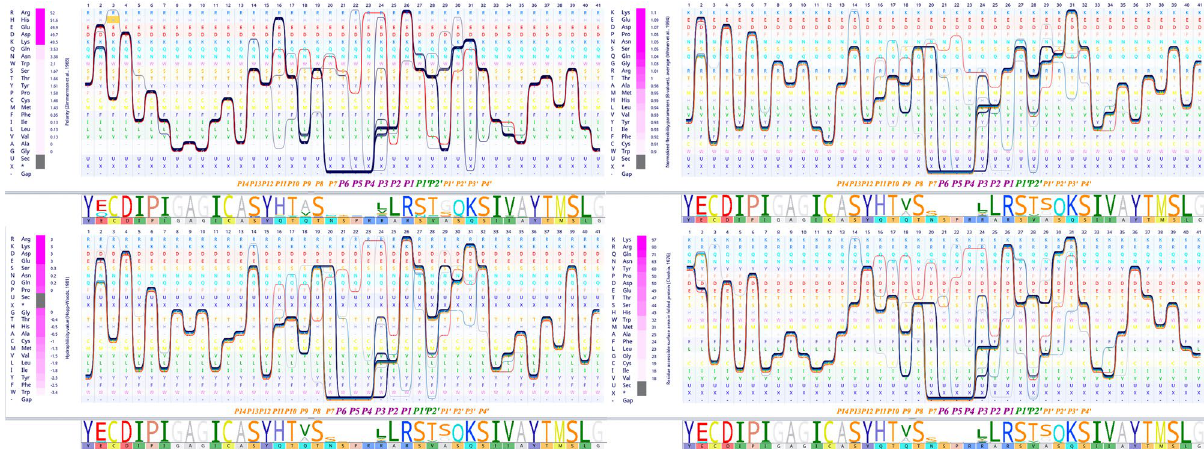
Figure 7. Comparison of the chemical properties of the furin cleavage site of SARS-CoV-2 spike glycoprotein with other coronaviruses. Four chemical properties of the furin cleavage site are compared with other coronaviruses by bundle illustrating the MSA. In each panel, the amino acids are sorted based on different chemical properties. The sequence logo and the sequence of SARS-CoV-2 spike glycoprotein furin cleavage sites are presented below each panel. The 20 amino acids of the furin cleavage motif are depicted by different colors on the top of the sequence alignment logo. The color scheme of fonts is based on the reference 38 . The red line in each panel is the sequence of the SARS-CoV-2 spike glycoprotein furin cleavage site.